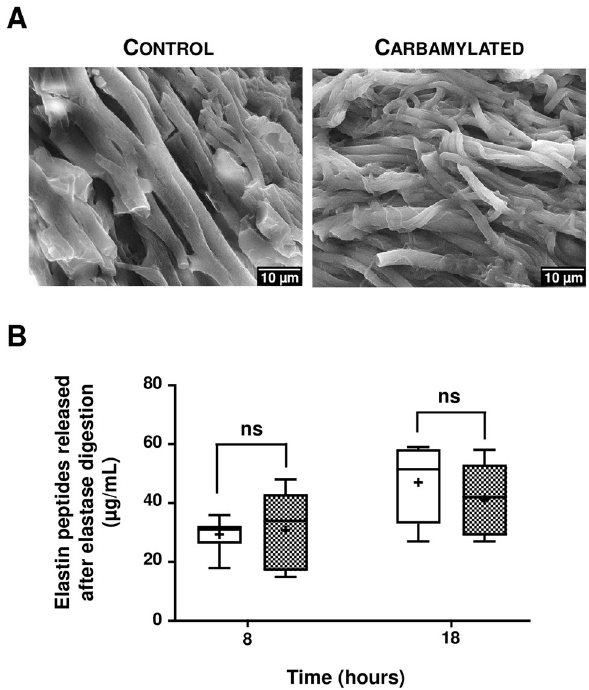
Figure 3. Impact of carbamylation on elastin morphology and sensitivity to elastase. ( A ) Representative SEM images of elastin extracted from bovine aorta and incubated with 100 mM NaCl (Control) or 100 mM NaCNO (Carbamylated) for 24 h at 37 °C. ( B ) Control (open boxes) and carbamylated (grey boxes) elastin samples were incubated with pancreatic elastase (0.1 UI/mL) for 8 and 18 h. Elastin peptides released into the supernatant after precipitation were quantified as described in “Methods” section. Results were expressed as μg/mL and presented as boxplots, in which the error bars represent minimum and maximum values, the horizontal bars and the crosses indicate median and mean values, respectively, and the extremities of the boxes indicate interquartile ranges. Values were compared using the non-parametric Mann–Whitney’s U test ( ns non